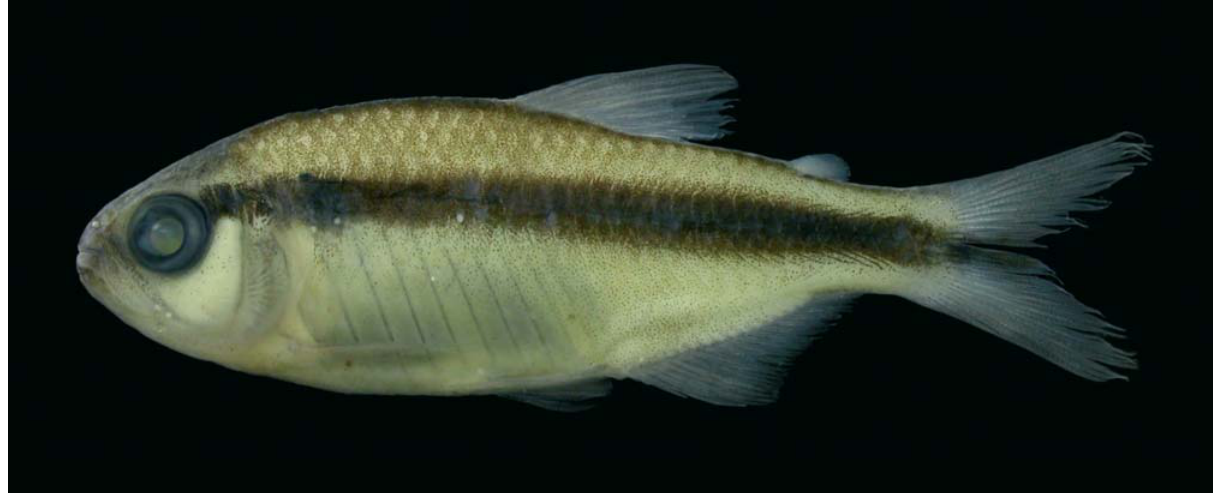
Fig. 1. Hyphessobrycon melanostichos , MCP 39510, holotype, 34.7 mm SL, female; rio Doze de Outubro, tributary of